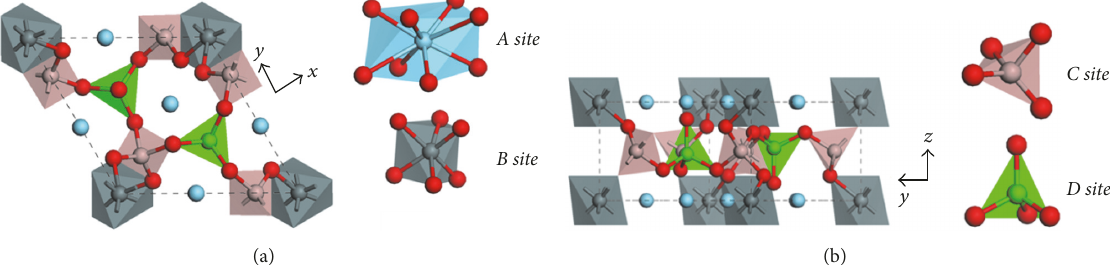
Figure 1: Crystal structure of A 3 BC 3 D 2 O 14 : (a) three-dimensional framework viewed along the 𝑐 -axis; (b) three-dimensional framework viewed along the 𝑎 -axis; the local distorted polyhedron of different cation sites, including decahedral A site, octahedral B site, tetrahedral C site, and tetrahedral D site.